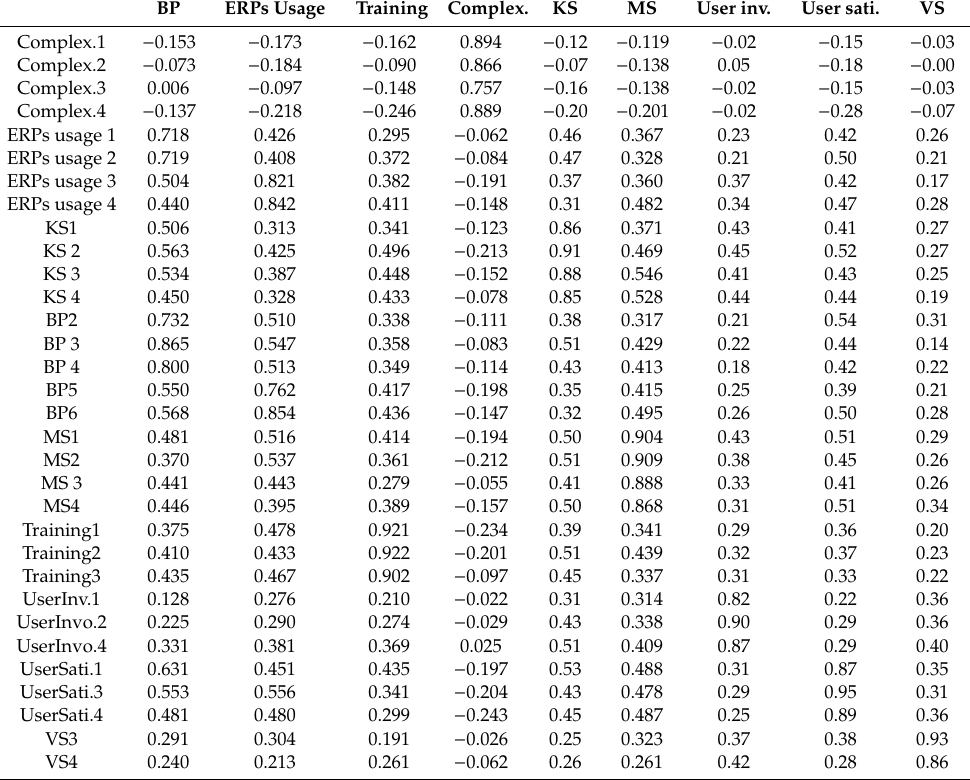
Table 6. The Item loading and cross-loading of